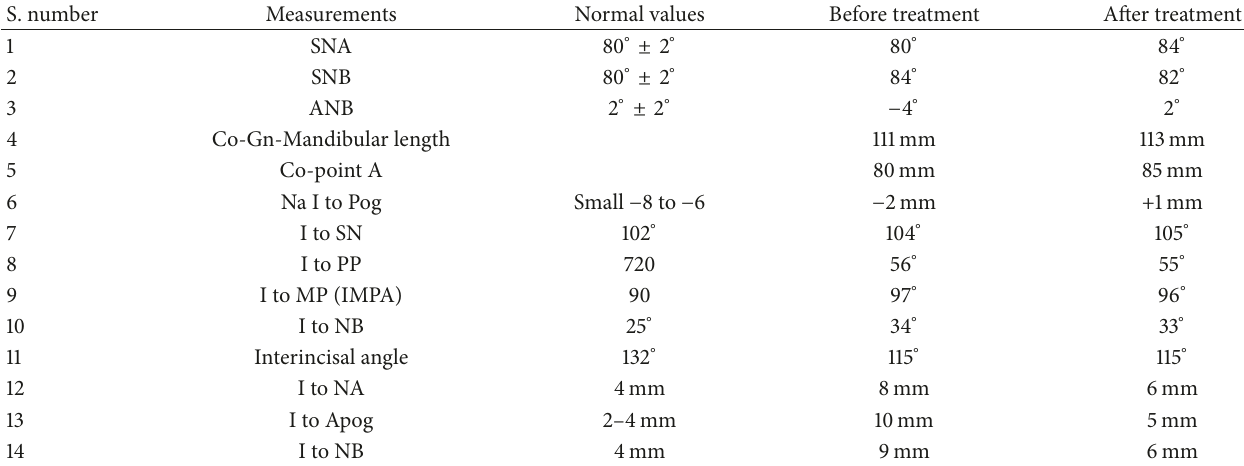
Table 1: Comprehensive cephalometric evaluation (sagittal and dentoalveolar).